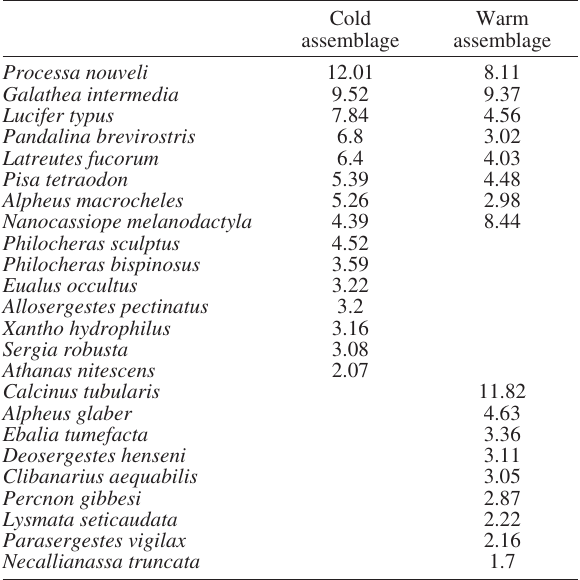
Table 3. – Values correspond to the percentage of similarity (SIM- PER analysis) of the species that contributed to 80% of average similarity for each